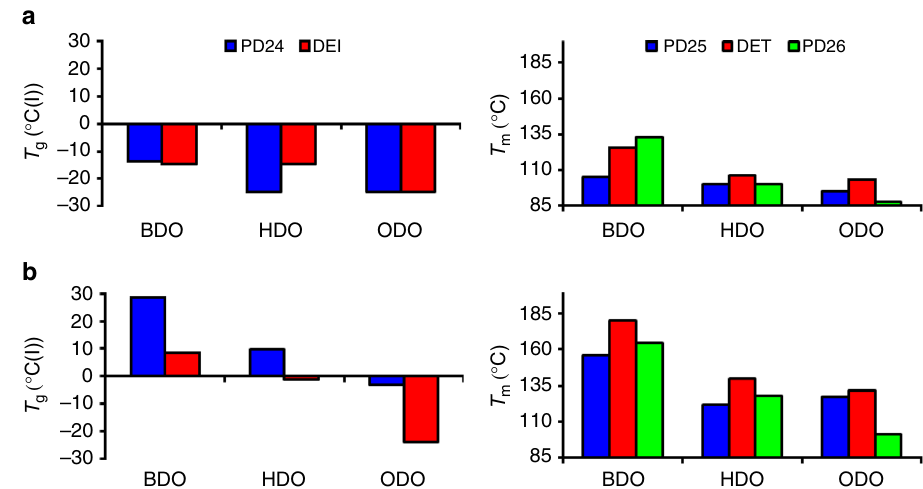
Fig. 4 DSC analysis of the polymers. Glass transition temperatures ( T g ) and melting temperatures ( T m ) of the polymers synthesized in ( a ) bulk and ( b ) diphenyl ether